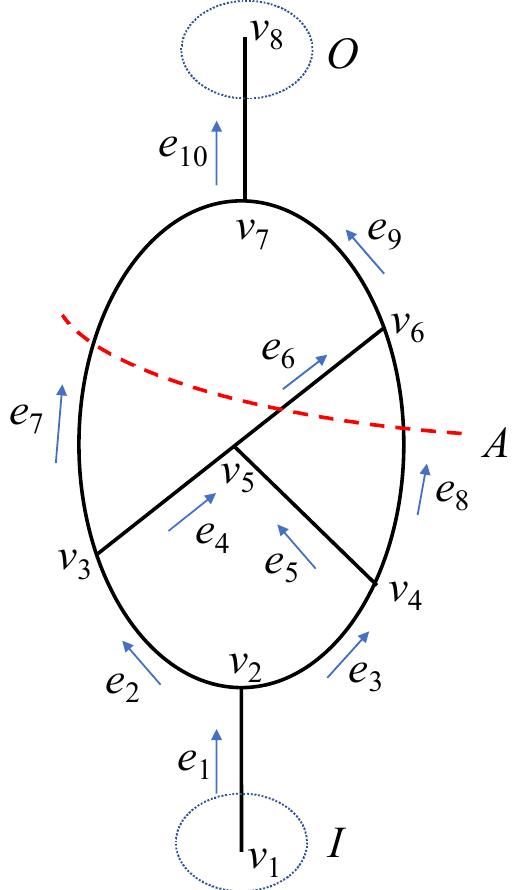
Figure 5. Schematic diagram of independent cut set. (Red line 𝐴 represents cut line, and 𝐼 and 𝑂 represent source junction and sink junction respectively).